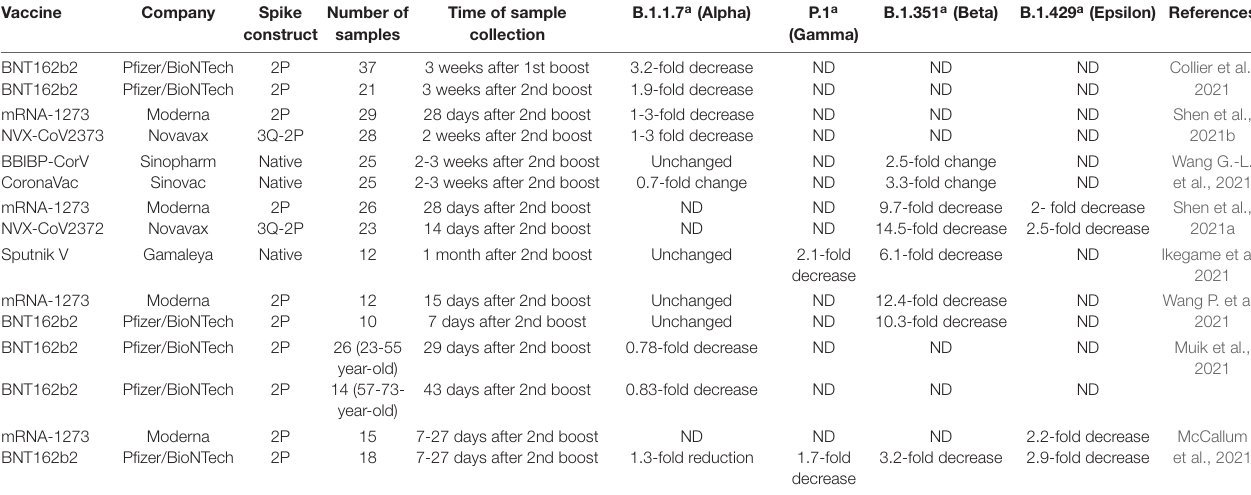
TABLE 2 | Summary of post-vaccine sera evaluated for neutralization potency by using pseudotyped VSV-Severe Acute Respiratory Syndrome-Coronavirus-2 (SARS-CoV-2) Spike variants of concern (VOC).